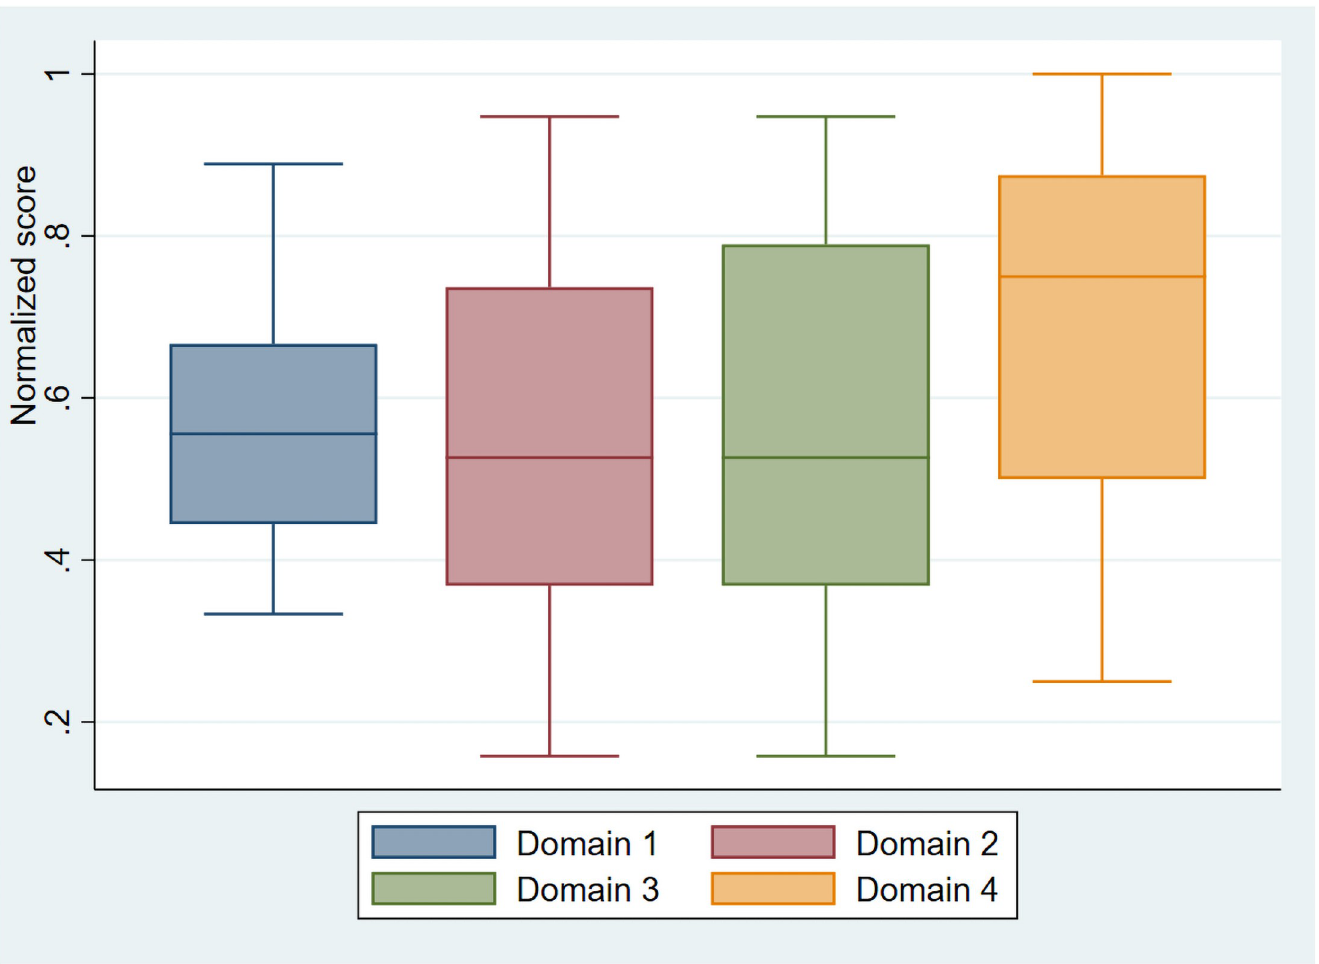
Fig 4. Boxplot showing respondent scores for four domains on knowledge of dengue management in Bhutan, 2019–2020. Domain 1: Transmission; domain 2: Clinical course; domain 3: Diagnosis and treatment; domain 4: Surveillance and prevention.